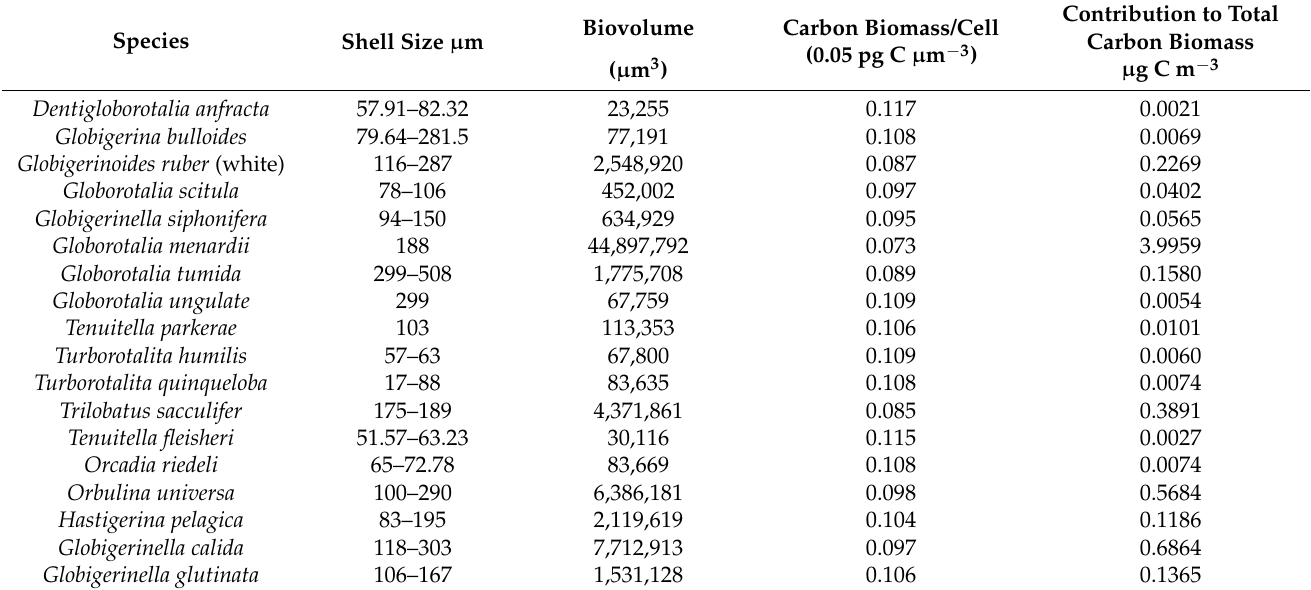
Table 2. The range of shell diameter ( µ m), the mean value of biovolume ( µ m 3 ), carbon biomass (pg C µ m − 3 ) of foraminifera species and its contribution to total carbon biomass ( µ g C m − 3) in the eastern Indian